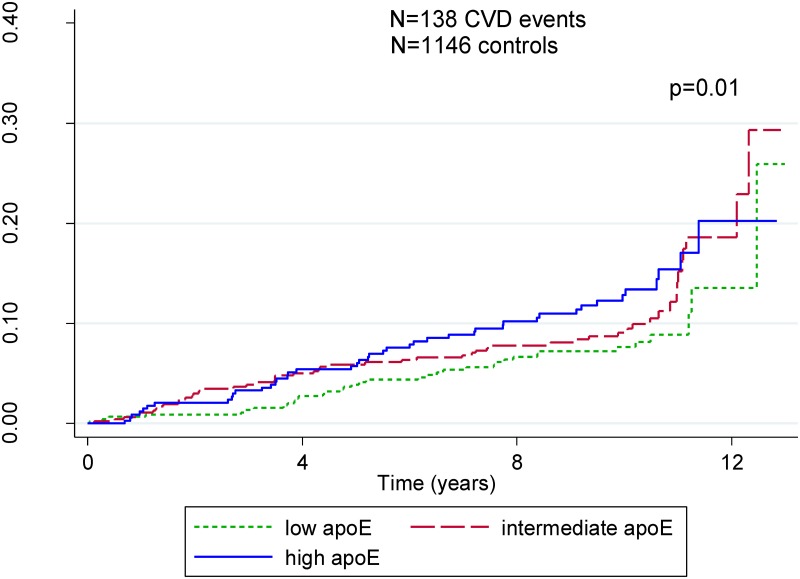
Kaplan-Meier plot for tertiles of ApoE concentration in individuals with ε3ε3 genotype.This analysis was conducted to overcome any effect of isoform or structural change in the circulating protein. High concentrations are indicated in blue, intermediate in red, and low in green. Precise time-to-event measures are available in NPHSII, and therefore analyses are restricted to this study. There is a marginally statistically significant relationship between ApoE concentration and time to CVD event; however, given that this analysis is restricted to one study, which included only men, it has to be interpreted with caution. CVD, cardiovascular disease.